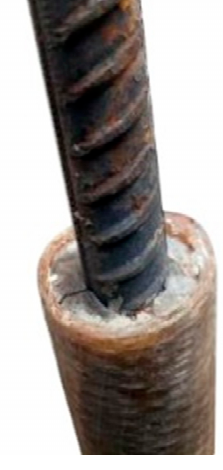
Figure 4. Global buckling failure mode of FCCC-R specimens.